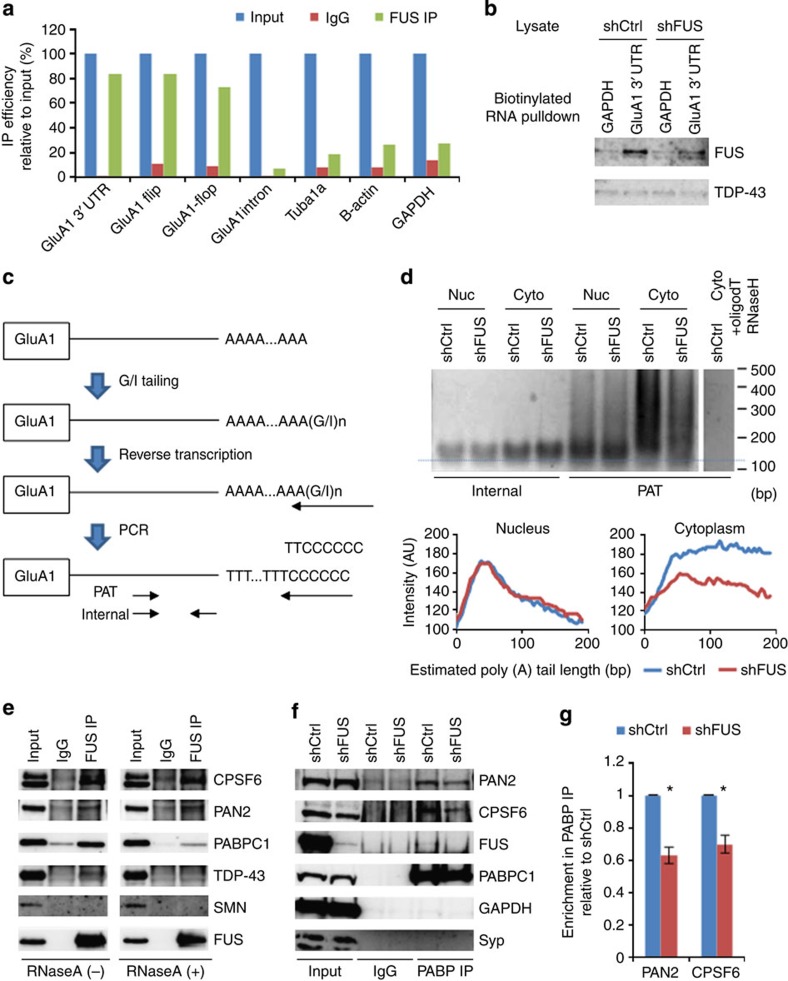
FUS-containing 3′ UTR processing machinery modulates GluA1 mRNA polyadenylation.(a) RNA IP of FUS in cultured cortical neurons. Bound RNA was analysed by RT–PCR using the indicated primers. IP efficiency was calculated relative to input. Representative data from triplicate experiments are shown. (b) Biotinylated RNA pull-down assay to assess endogenous FUS binding to biotinylated RNA for GluA1 3′UTR or control GAPDH mRNA. Each biotinylated RNA was incubated with lysate either from control or from FUS knockdown cortical neurons and analysed by western blot. TDP-43 served as a negative control. (c) Scheme of GluA1 mRNA poly (A) tail length (PAT) analysis. (d) The polyadenylation assay was performed using nuclear (Nuc) and cytoplasmic (Cyto) RNA from control and FUS knockdown cortical neurons. Cytoplasmic RNA from control cortical neurons was treated with RNase H in the presence of oligo dT and served as negative control. Smear signals were quantified by ImageJ software and plotted against the length of poly (A) tail calculated based on the size marker. (e) Co-IP of FUS in mouse brain lysate with or without RNase A treatment. Bound proteins were detected by western blot using the indicated antibodies. (f) Co-IP of PABPC1 using lyates from FUS knockdown and control primary cortical neurons. (g) Quantification of PAN2 and CPSF6 Co-IP levels in f (n=3; PAN2: t=7.341, *P=0.018; CPSF6: t=5.556, *P=0.031, paired t-test). GAPDH, glyceraldehyde 3-phosphate dehydrogenase.